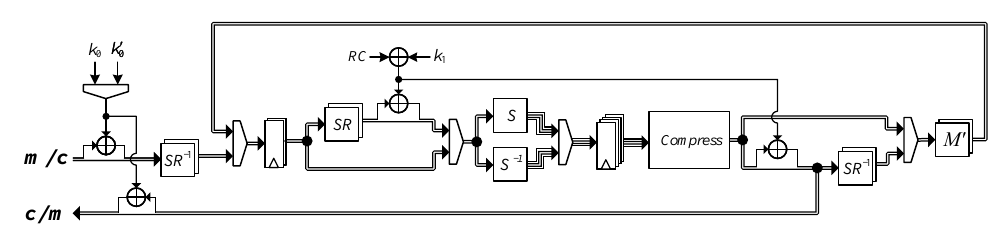
Figure 3: 2-share masked round-based PRINCE enc/dec without any fresh